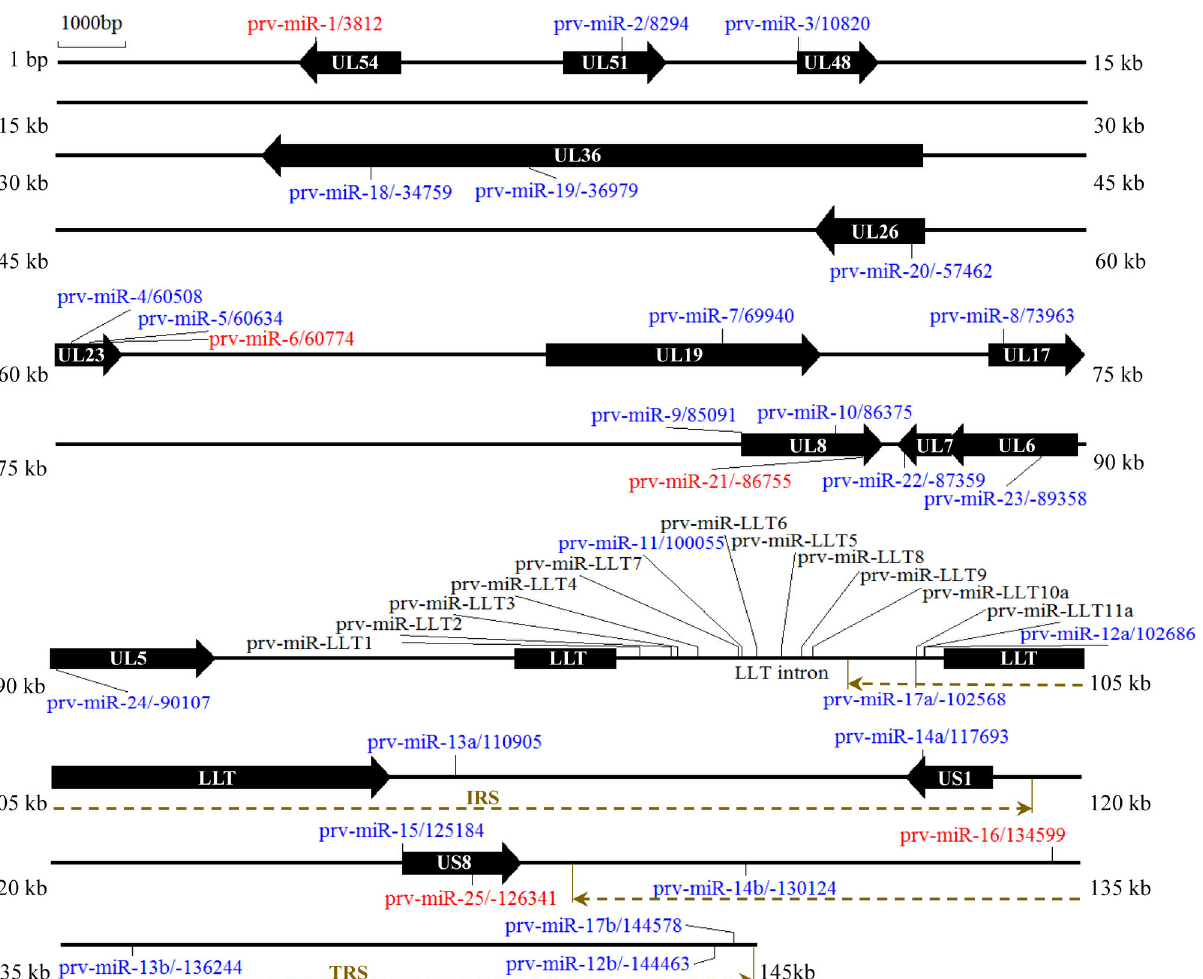
Fig 4. Location of virally encoded miRNA in the PRV JS-2012 genome. The relative positions of the known and predicted novel miRNAs in the JS-2012 genome are shown. The linear form indicated PRV JS-2012 genome. The black arrows indicated predicted miRNAs locations in ORFs of PRV JS-2012. The known miRNAs were indicated with black font. Validated putative miRNAs were indicated with blue font and non-validated putative miRNAs were indicated with red font. The figure showed only ORFs contained the viral miRNAs, virus others genes and 5 ’ or 3 ’ UTRs, DNA repeats, splice sites, and origin of replication were not